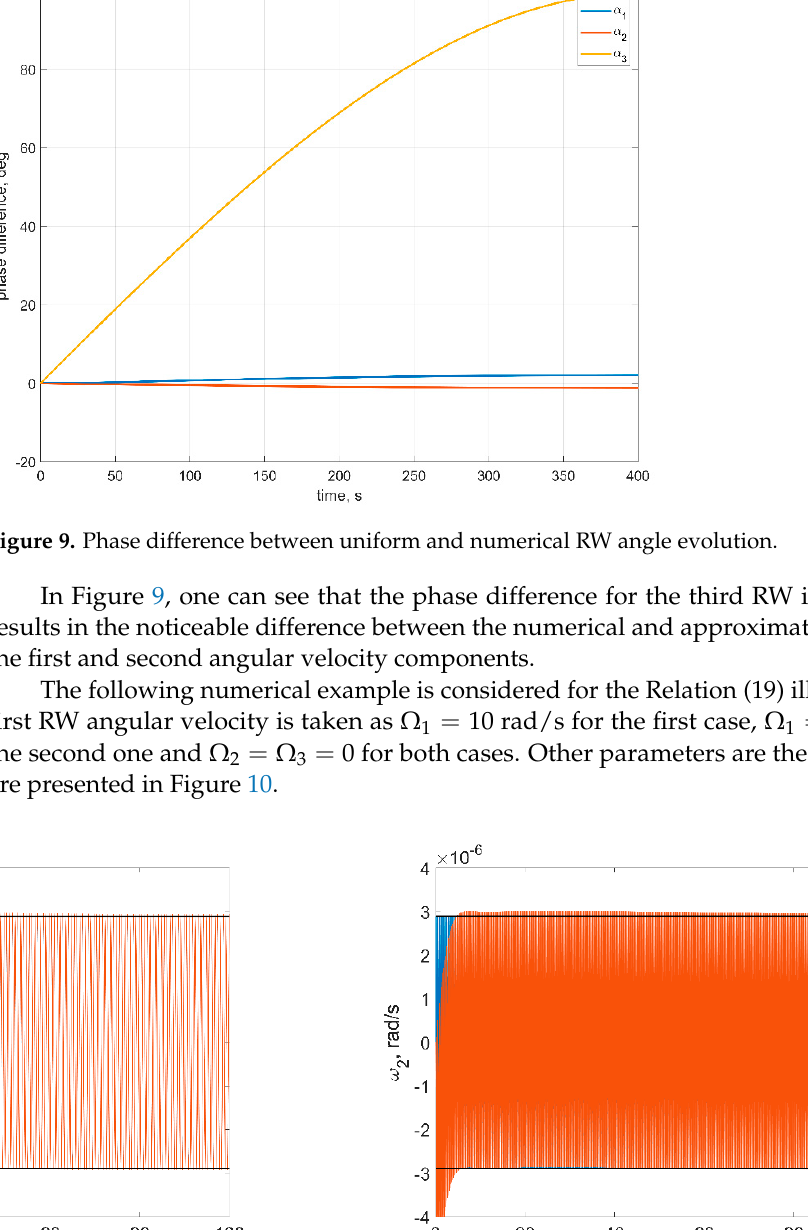
50 sec Ω = ( right ). Figure 10. Stabilization accuracy for Ω = 50 s − 1 ( right